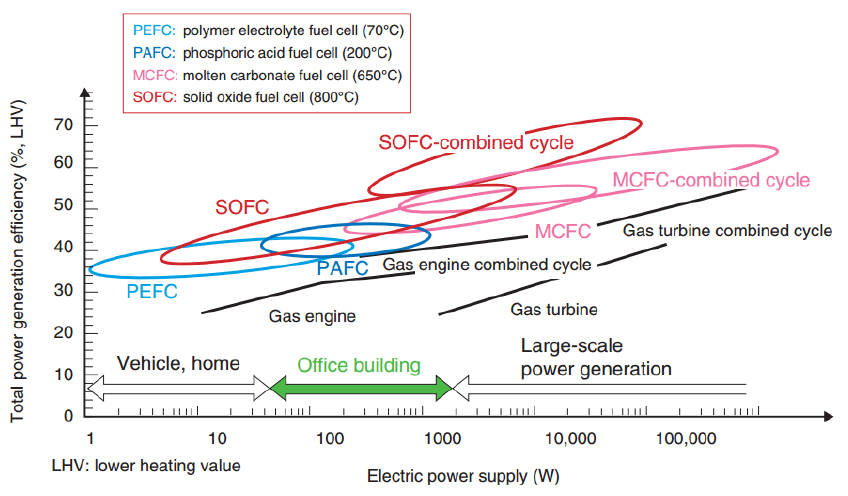
Figure 1. Total power generation efficiency of various fuel cells for the electric power output [4].